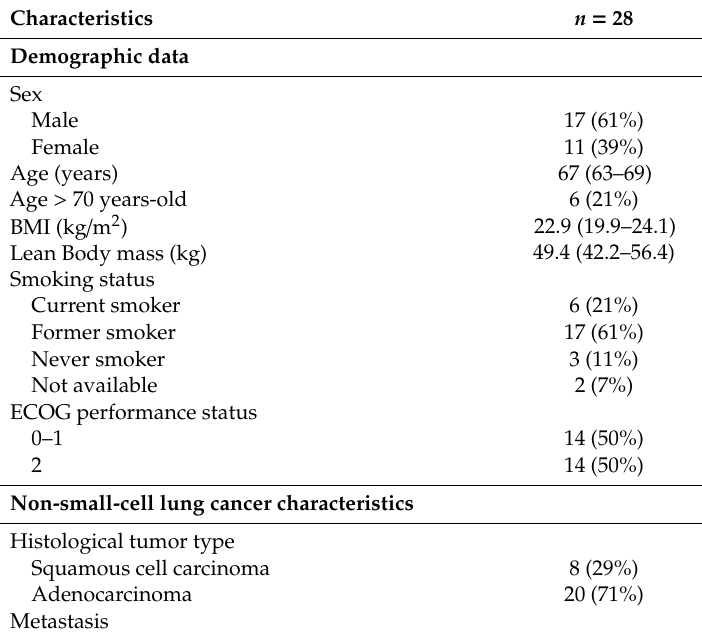
Table 1. Demographic and baseline characteristics of